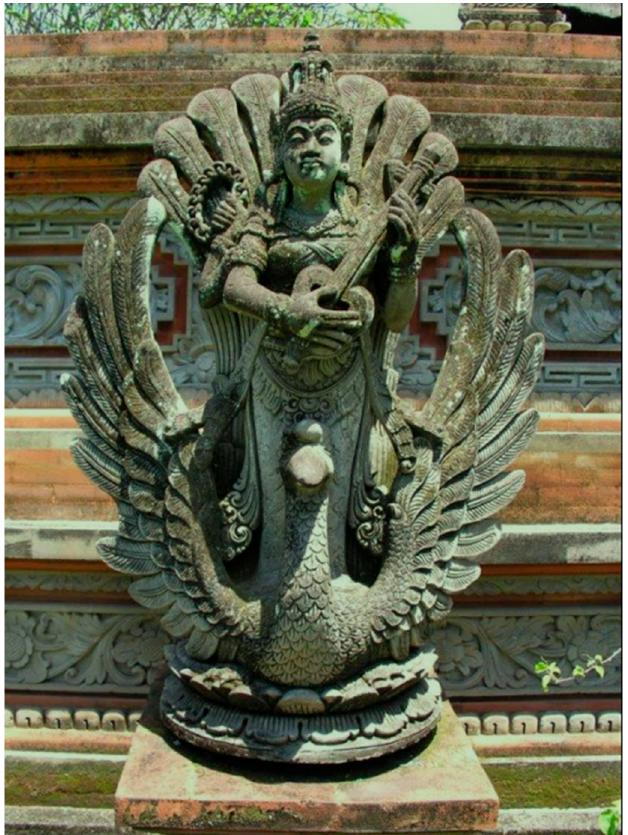
Figure 7. On Garuda, Vishnu holds a lute. In the Nageri Propinsi Museum, Bali 22 (Esipova 2018, p. 26).